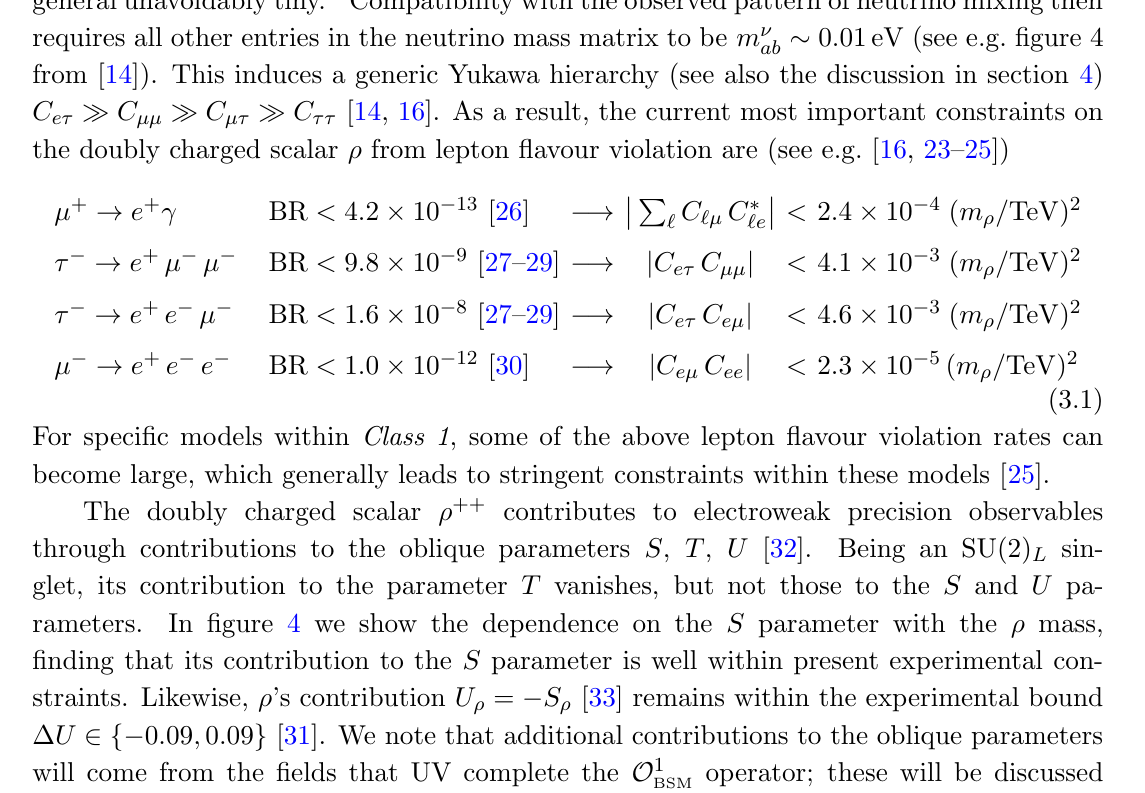
0 : 10 [31], with S = 0 from the (cid:6)